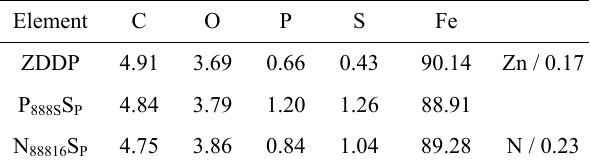
Table 3 Element mass content of wear scars lubricated